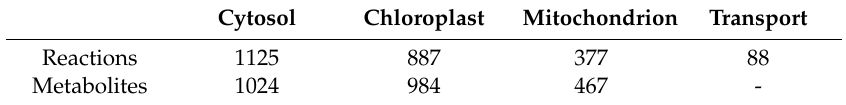
Table 1. Distribution of reactions and metabolites in di ff erent compartments of the model i Thaps987. Cytosol Chloroplast Mitochondrion Transport